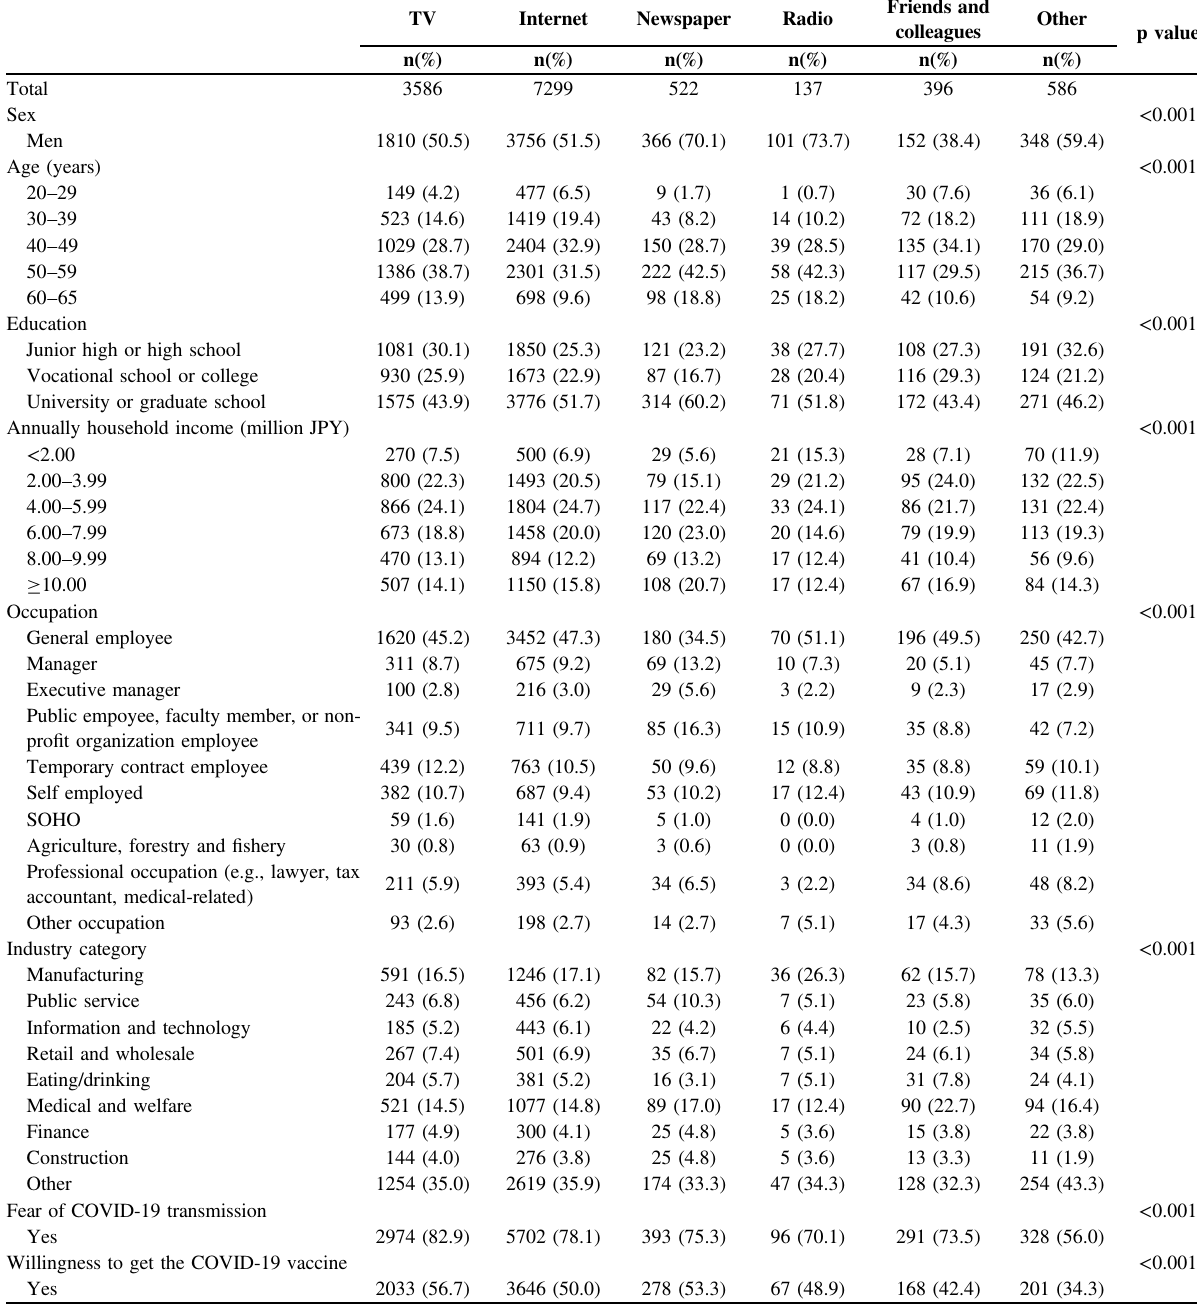
Table 1 Characteristics of the study population by information source